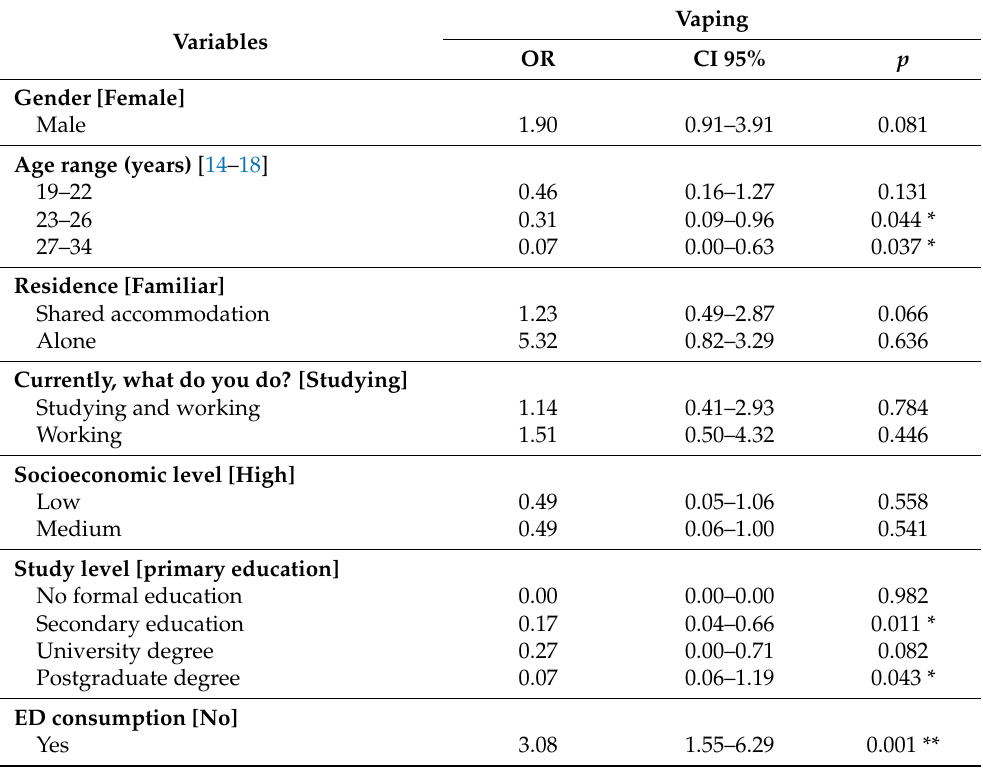
Table 5. Odds ratio values